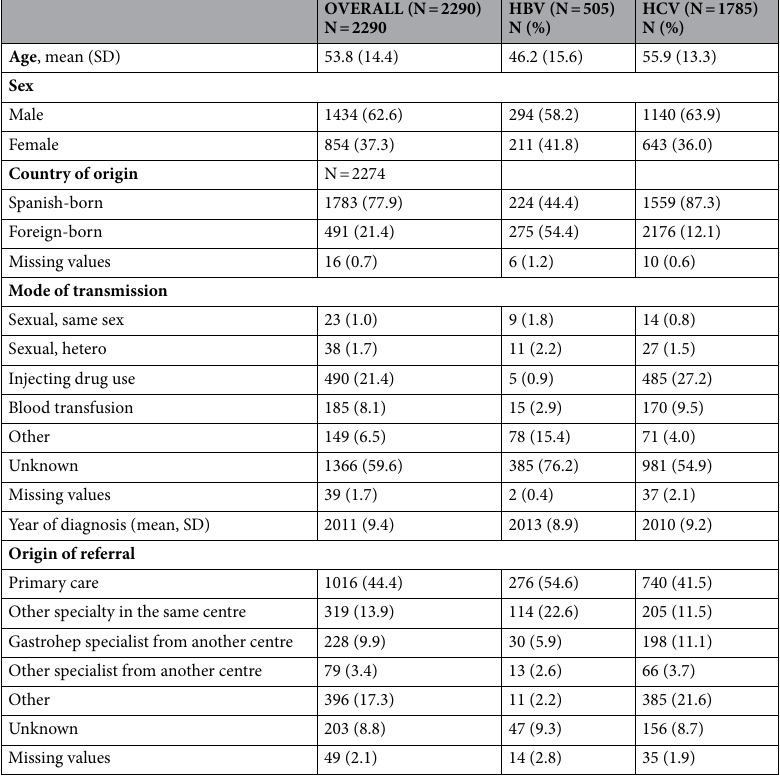
Table 1. Baseline characteristics of all patients included in the 11 Spanish centres, 2018/19. HBV hepatitis B virus, HCV hepatitis C